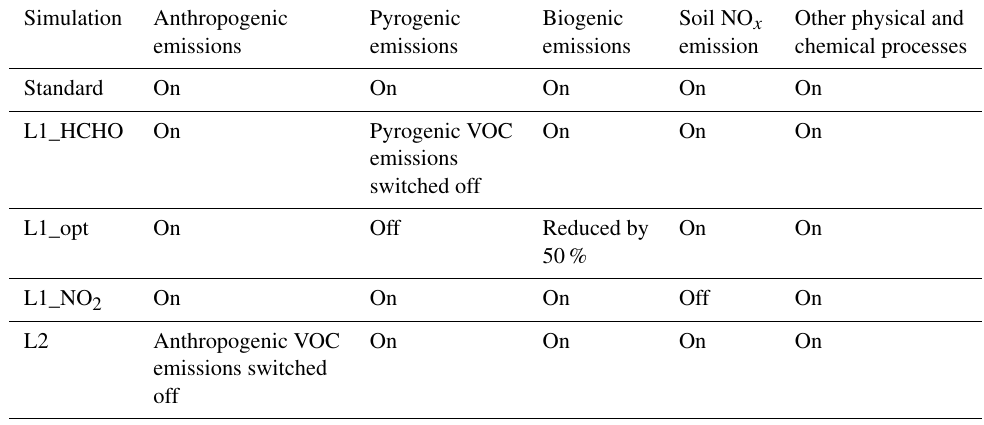
Table 3. Settings of the CHASER simulations used in this study. Simulation Anthropogenic Pyrogenic Biogenic Soil NO x Other physical and emissions emissions emissions emission chemical processes Standard On On On On On L1_HCHO On Pyrogenic VOC On On On emissions switched off L1_opt On Off Reduced by On On 50% L1_NO 2 On On On Off On L2 Anthropogenic VOC On On On On emissions switched